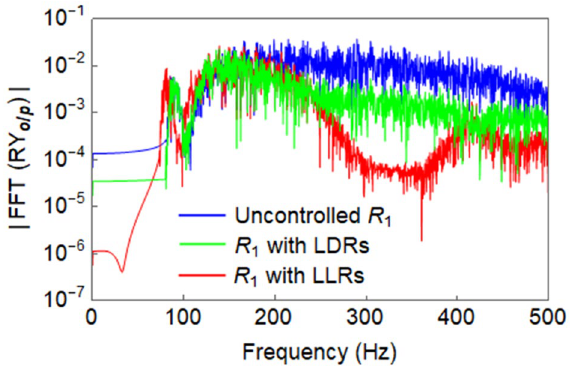
Figure 12. Comparison between the FFT of RY o / p of the uncontrolled R 1 against R 1 with LLRs and LDRs in the lateral